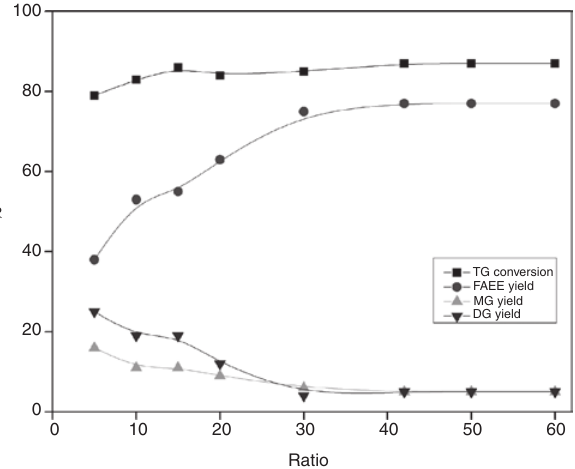
Figure 8: Effect of molar ratio at reaction conditions: temperature 340 ° C and 30